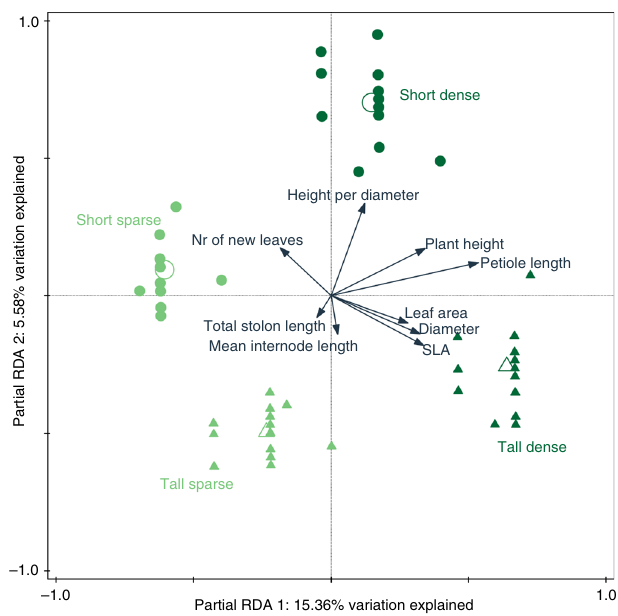
Fig. 2 Multivariate comparison of the responses of P. reptans to the different treatments. Ordination diagram of a partial redundancy analysis, with the explained variation of the fi rst partial RDA axis 15.36% (pseudo- F = 8.9, P = 0.001, n = 48, permutations n = 999 for each test) and of the second partial RDA axis 5.58% (pseudo- F = 3.5, P = 0.021, n = 48). Each of the treatments independently accounted for a signi fi cant amount of variation in the plastic responses of P. reptans : short-sparse (9%, pseudo- F = 5.1, P = 0.002, n = 10), short-dense (5.3%, pseudo- F = 2.8, P = 0.022, n = 12), tall- sparse (4.5%, pseudo- F = 2.4, P = 0.046, n = 13) and tall-dense (11.4%, pseudo- F = 6.5, P = 0.002, n = 13). Arrows represent the assumed linear change of traits as the response variables along the ordination axes. Full symbols represent the individual observations and open symbols the centroids of factor predictors: light green circles, short-sparse; dark green circles, short-dense; light green triangles, tall-sparse; dark green triangles,